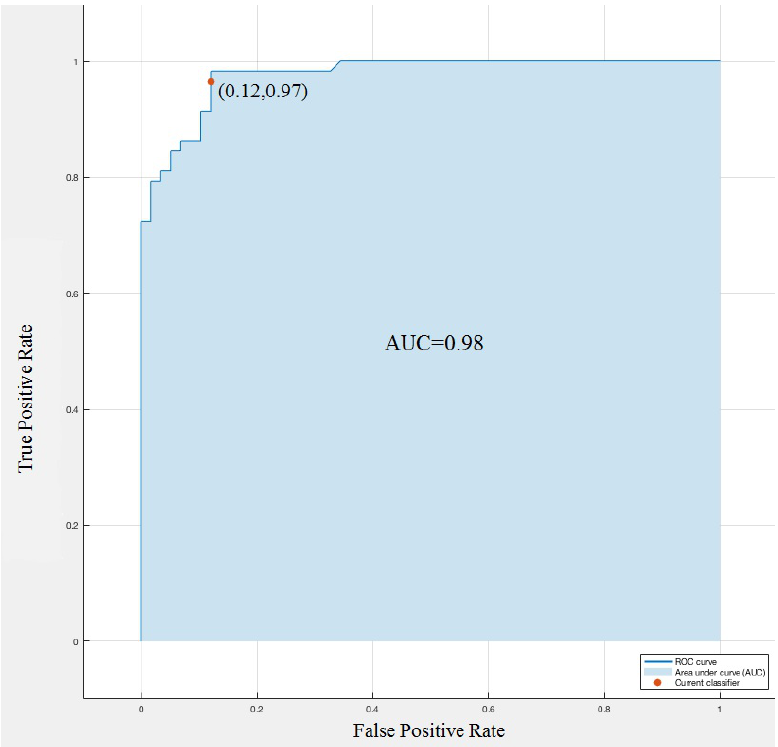
Figure 6. ROC curve of innocent and pathological murmurs